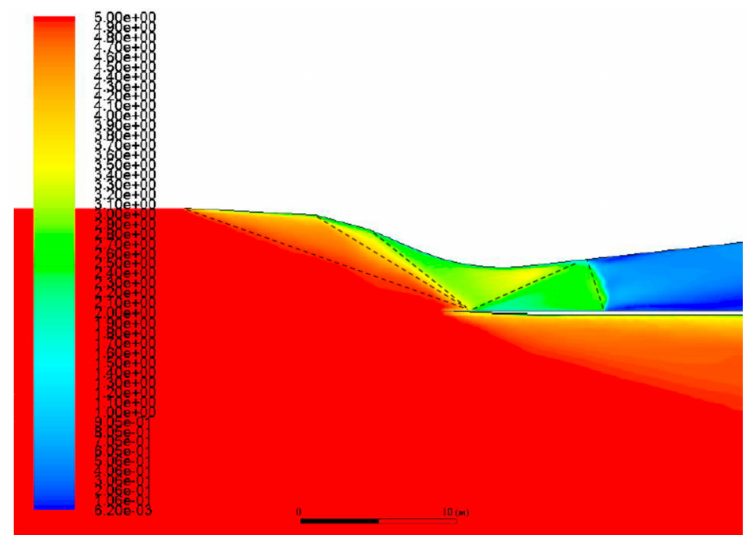
Figure 7. Mach 5.0 Mach contour.